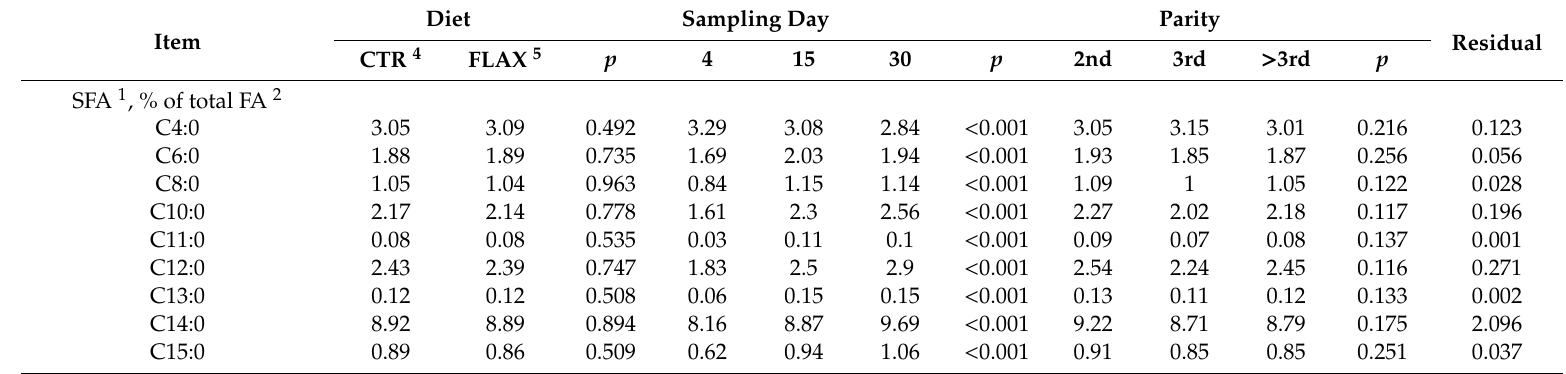
Table 4. E ff ect of flaxseed supplementation during dry period, sampling day, and parity on the fatty acid profile in early and commercial milk of Holstein cows during the first 30 d of the subsequent